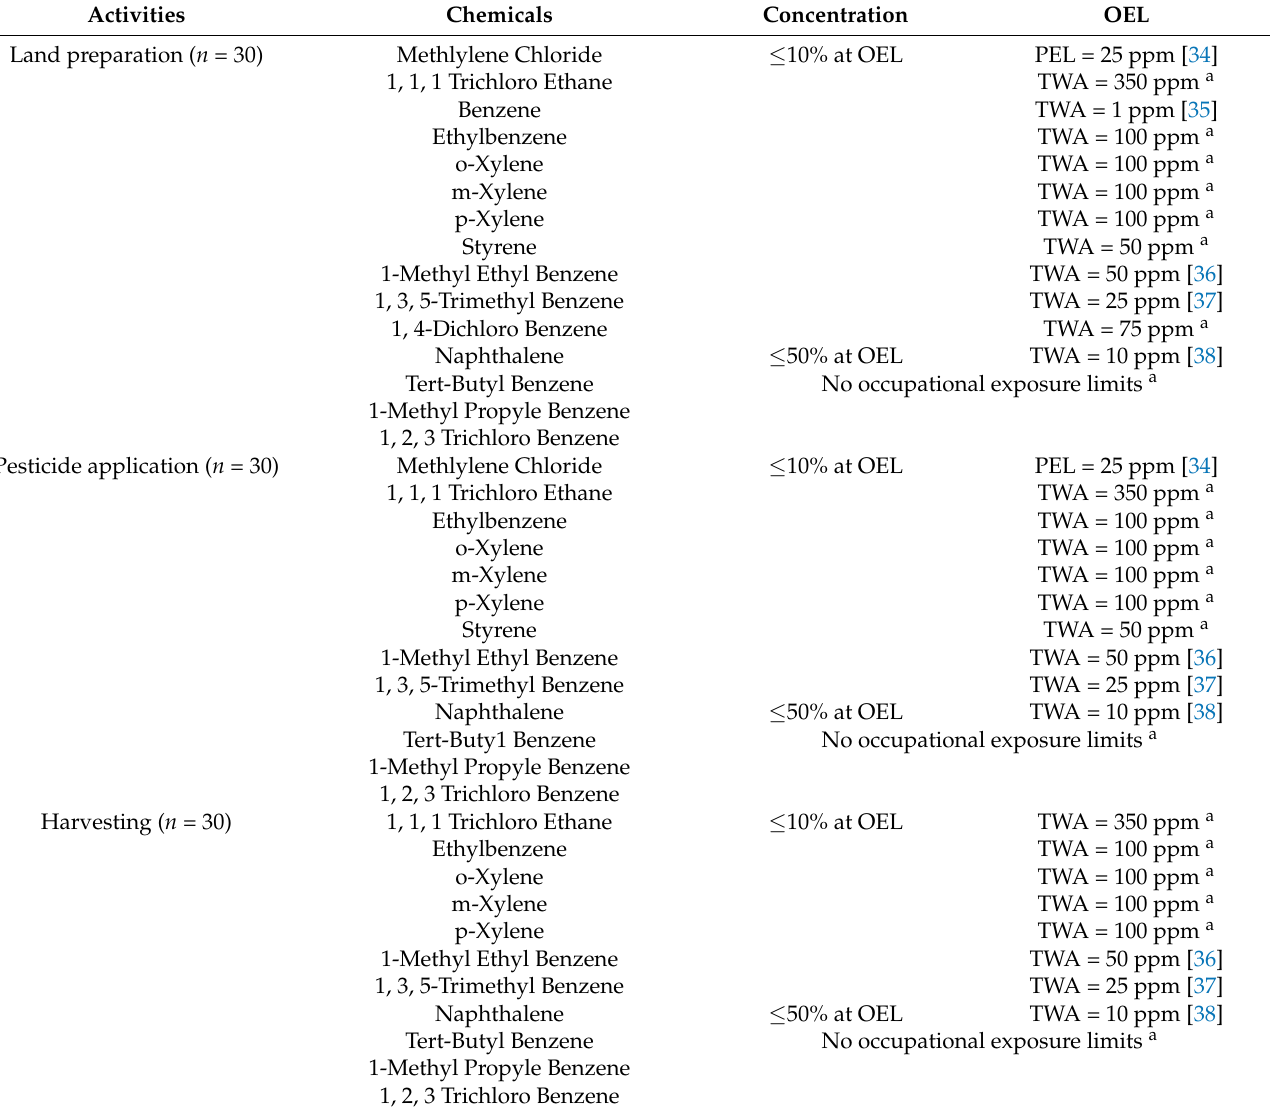
Table 3. Detection frequency and average concentrations of VOCs in personal